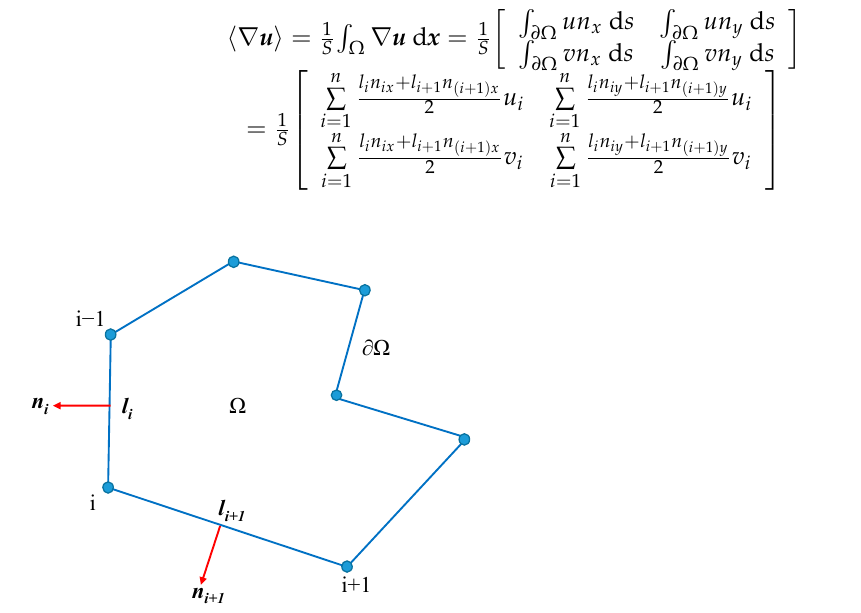
Figure 4. The notation li and n i in H.